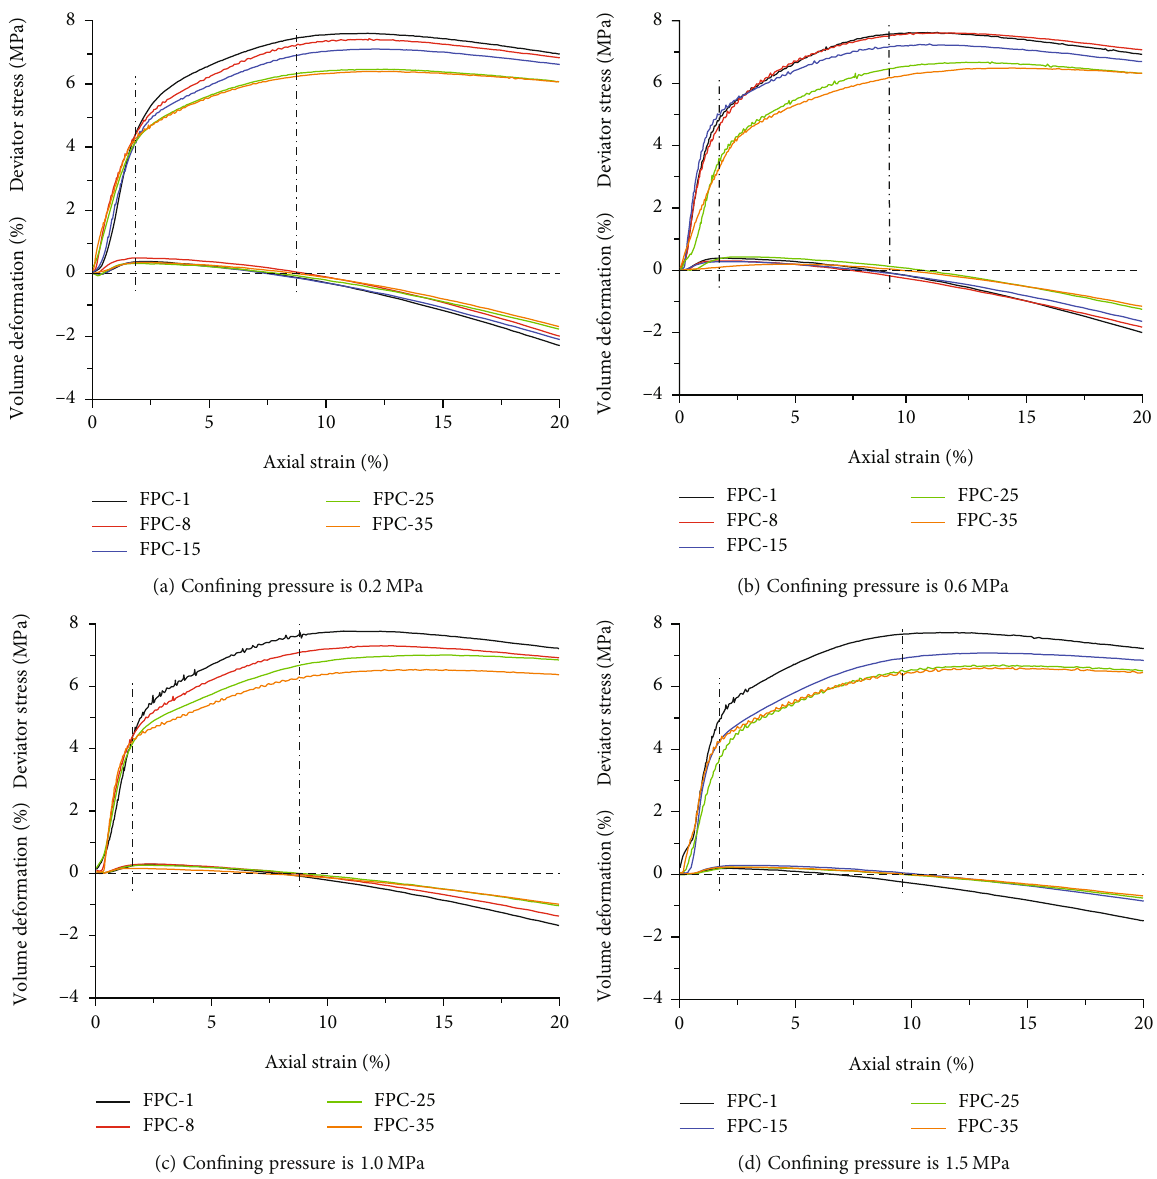
Figure 4: Stress-strain curves and volume deformation curves of frozen silty sand under di ff erent con fi ning